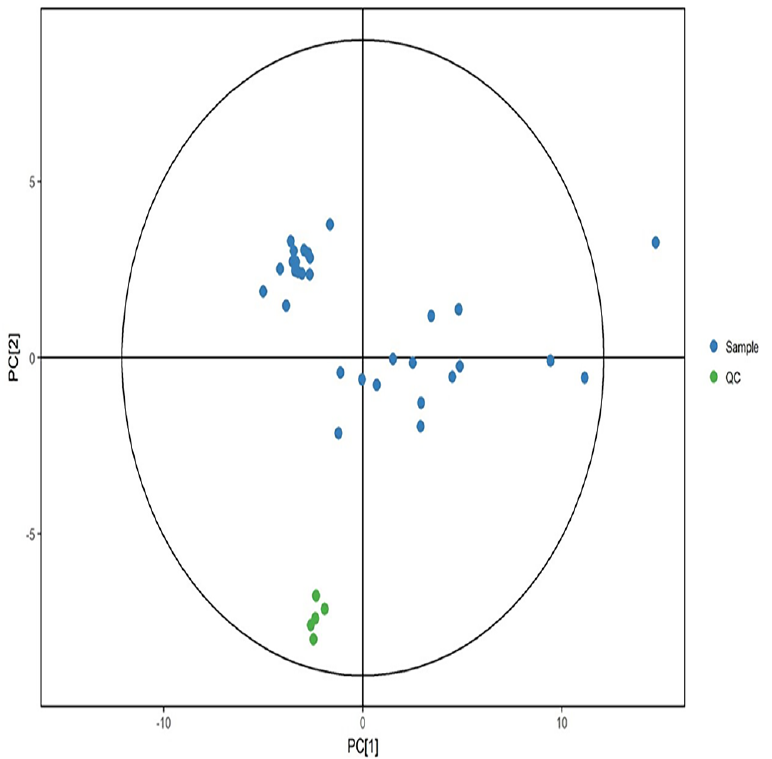
4 Figure 4. PCA score in negative ion mode. Green dots represent quality control samples, and blue dots represent study